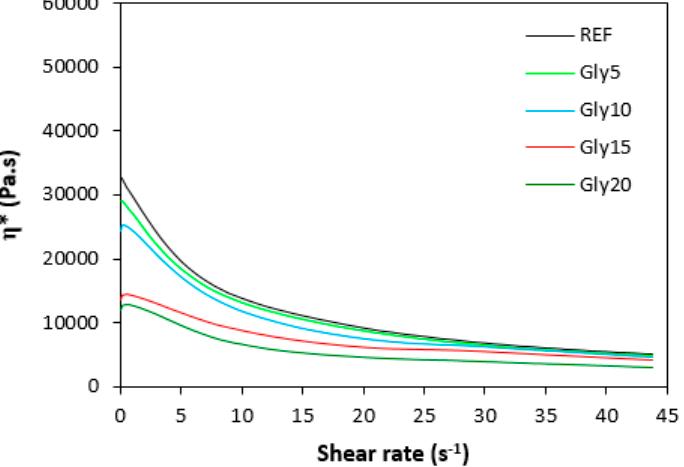
Figure 10. Dependence of dynamic complex viscosity ( η *) of rubber compounds based on NBR on shear rate.